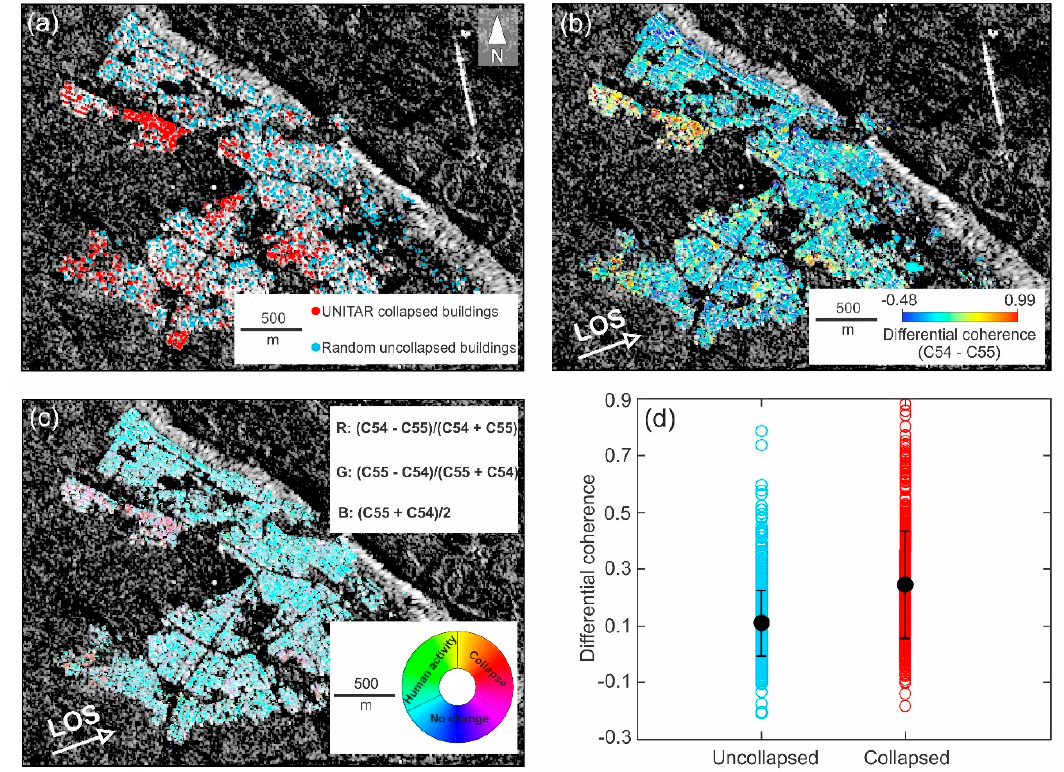
Figure 6. Damage in Sarpole-Zahab from optical and radar imagery. ( a ) Locations of 683 collapsed buildings (red circles) extracted by UNITAR from pre-event WorldView 3 satellite (30 m resolution) and post-event optical data from the Pleiades satellite (50 m resolution). The blue circles are 683 randomly selected uncollapsed buildings; ( b ) Damage map from the SSSC method; ( c ) RGB color composition map; ( d ) Differential coherence ( ∆ γ ) values of two damage levels deduced from the SSSC method.